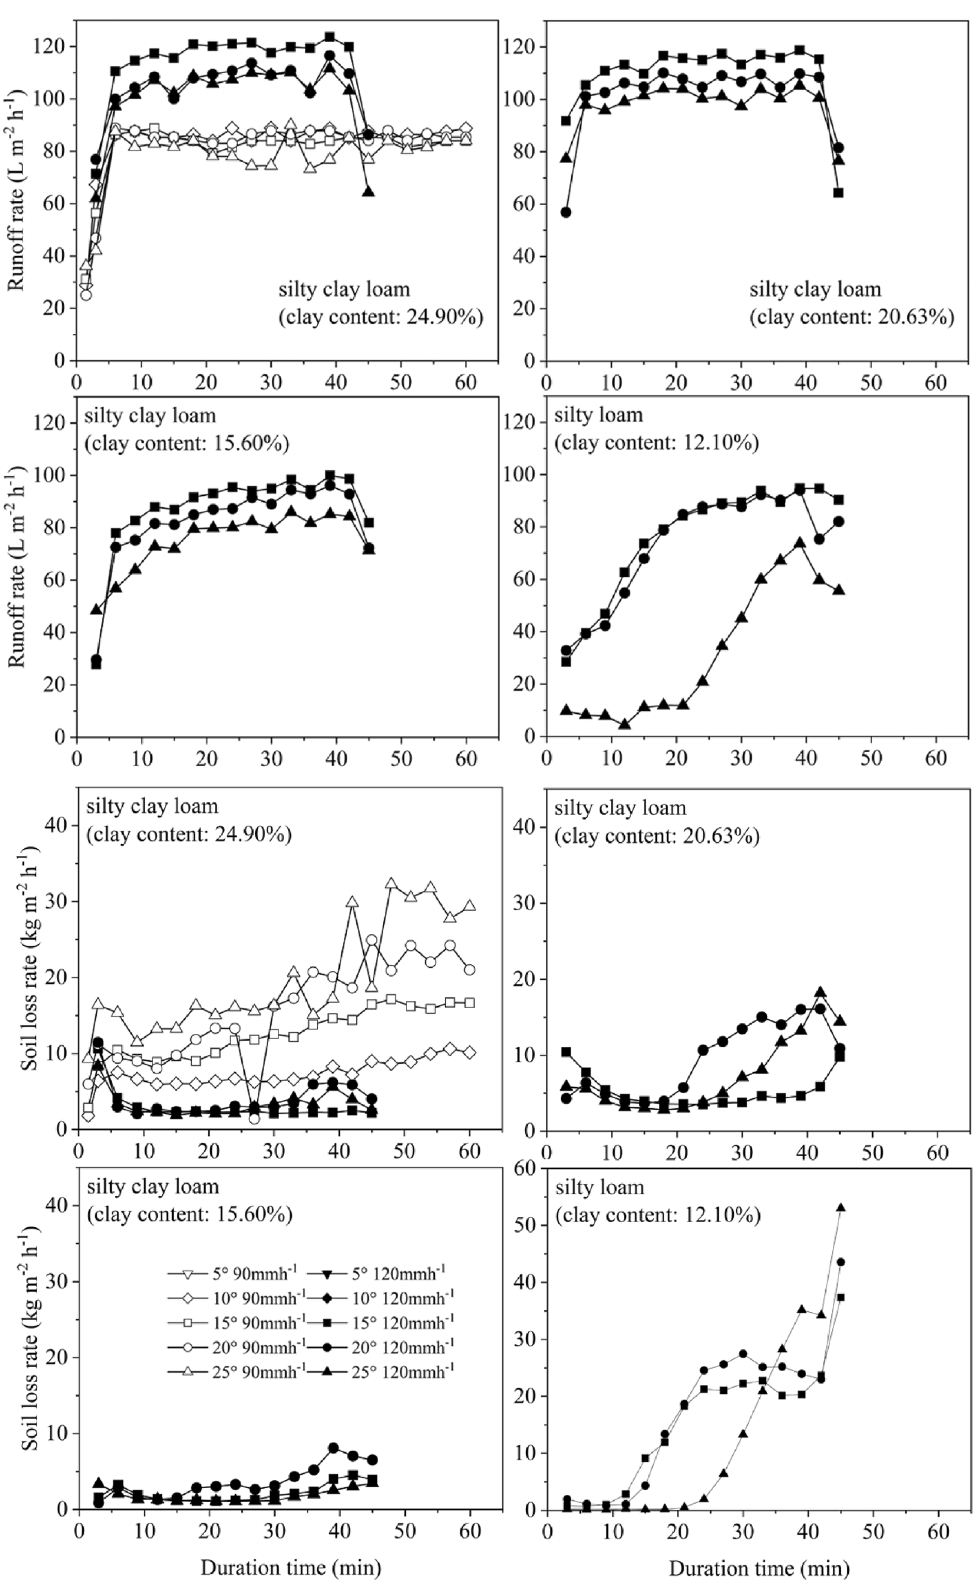
Fig. 3 Temporal variations of runoff rate and soil loss rate for